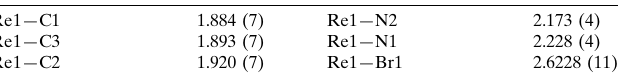
Selected bond lengths (A˚